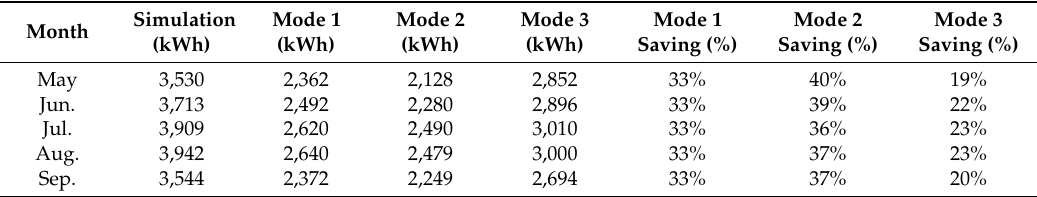
Table 10. Monthly energy consumption under the continuous and different modes of AC operation for Flat during the